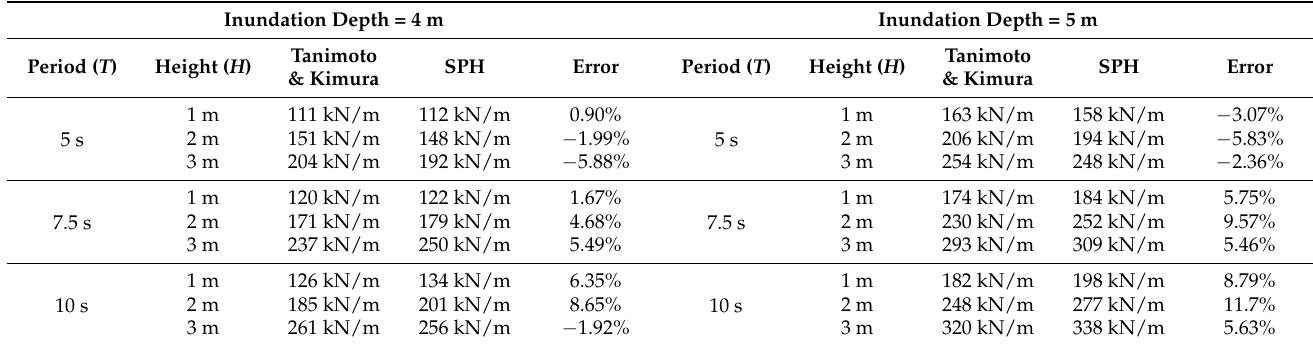
Figure 10. Parameters used for the computation of maximum wave pressures on sloped barriers per Tanimoto and Kimura [58]. Table 2. Summary of empirical and SPH maximum wave forces on the sloped floodwall as shown in Figure